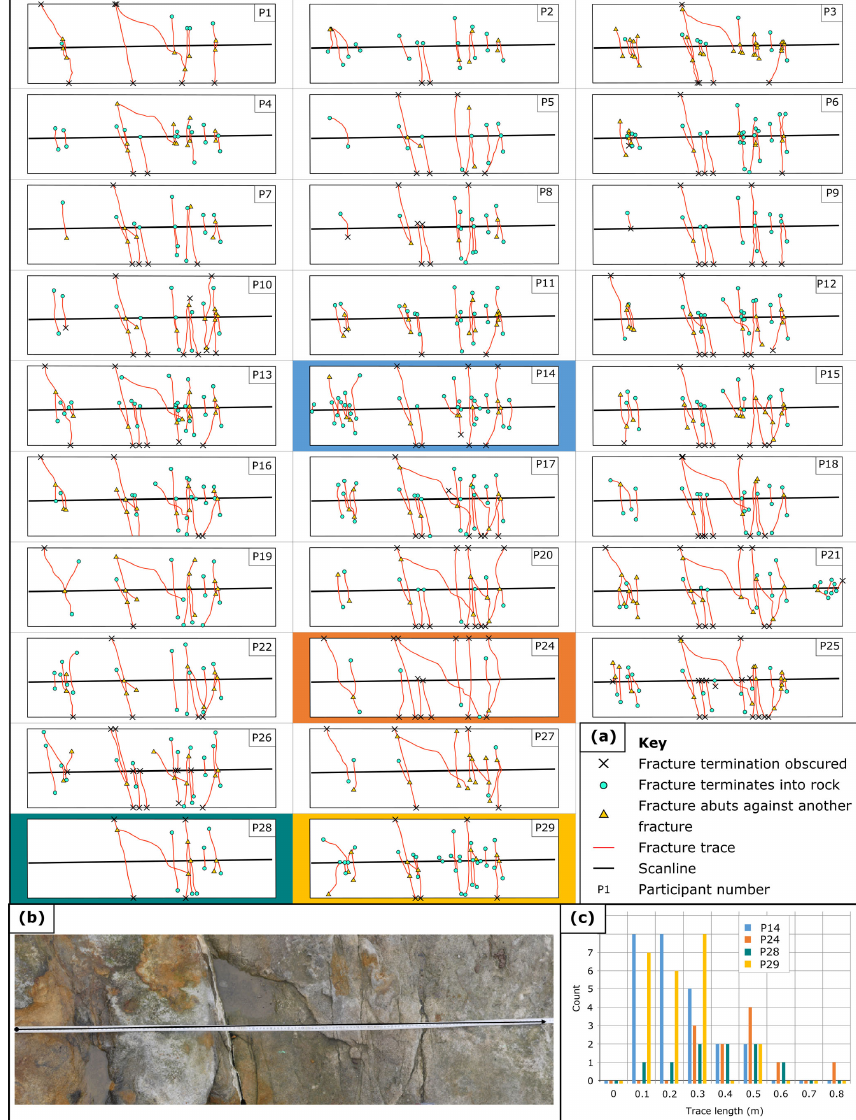
Figure 2. The interpreted fracture traces for Line 6 (length 1.45m). (a) The digitised fracture networks for all workshop participants. (b) Field photograph of Line 6. (c) Fracture trace length histograms (bin = 0.1m) for participants who recorded a low to high number of fractures. The corresponding digitised fracture trace is also highlighted in the appropriate colour. Key differences in the interpreted fracture networks are highlighted using participants who selected a low (Participant 28, nine fractures), medium (Participant 10, 17 fractures), and high (Participant 14, 25 fractures) number of